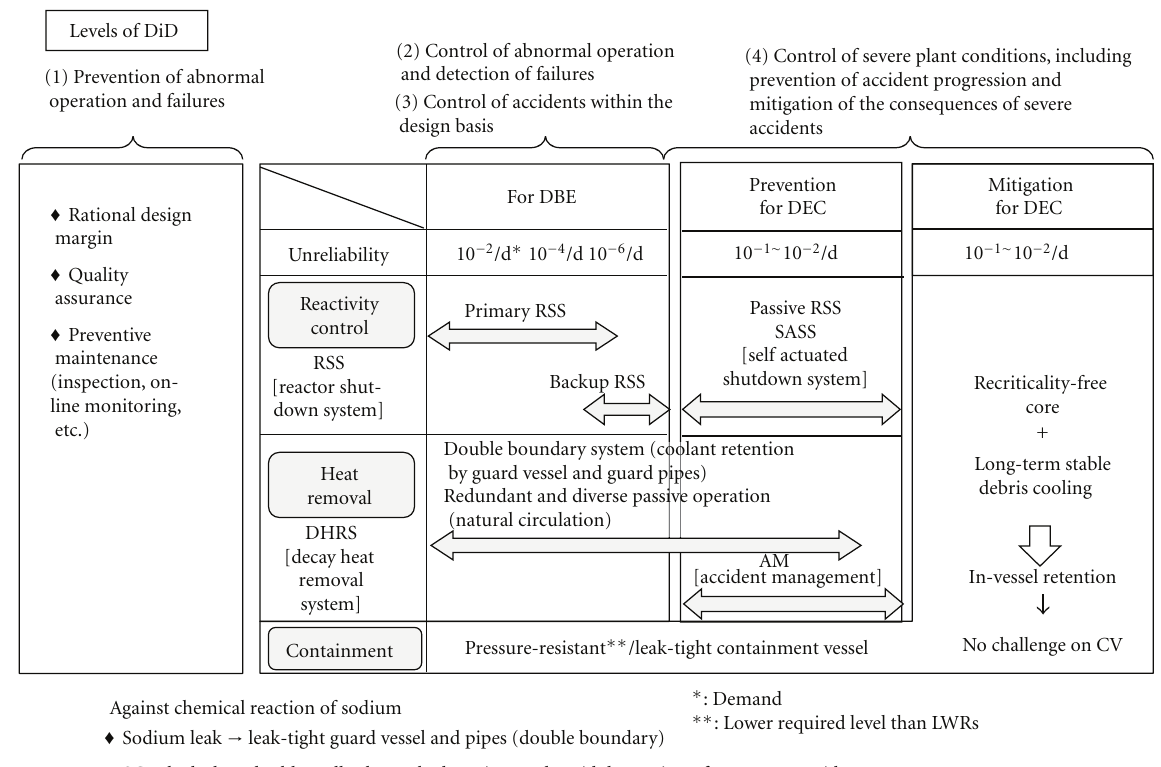
Figure 1: Basic framework of safety design in